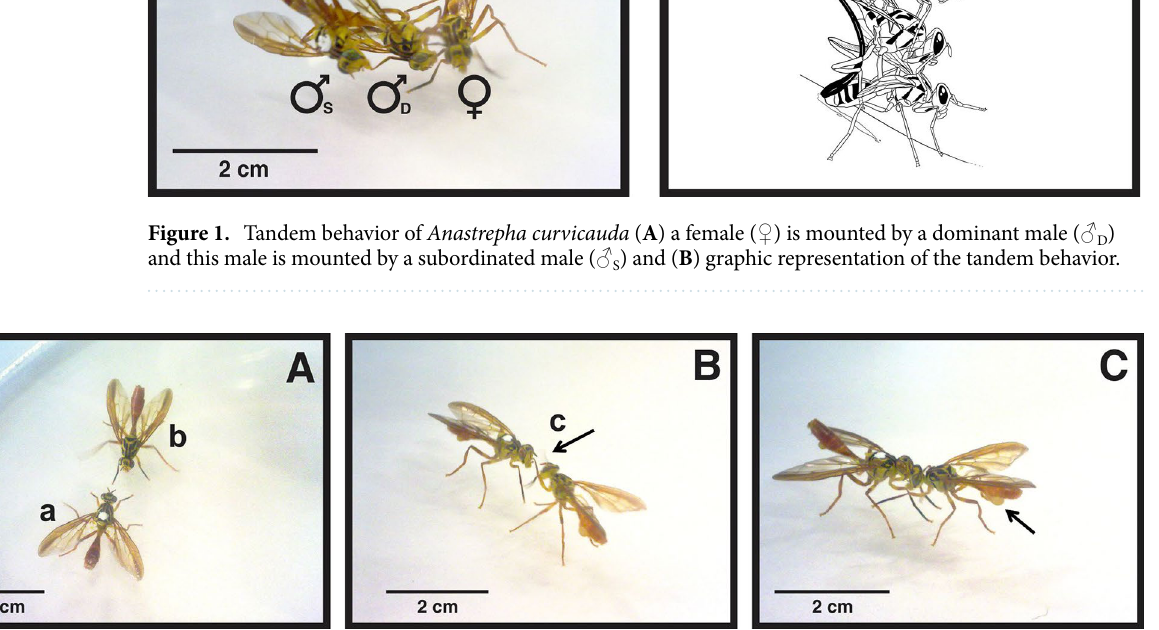
Figure 2. Agonistic behaviors displayed by Anastrepha curvicauda . ( A ) Threat: male (b) is threatening male (a). Male (b) raises its abdomen at a sharp angle, folds back its wings, and waves its middle legs up and down making a characteristic sound, ( B ) Attack: the male on the right is striking the other male in the head with his forelegs. The arrow indicates the forelegs hitting the head of the rival, ( C ) Fight between males. Arrow indicates expanded pleural